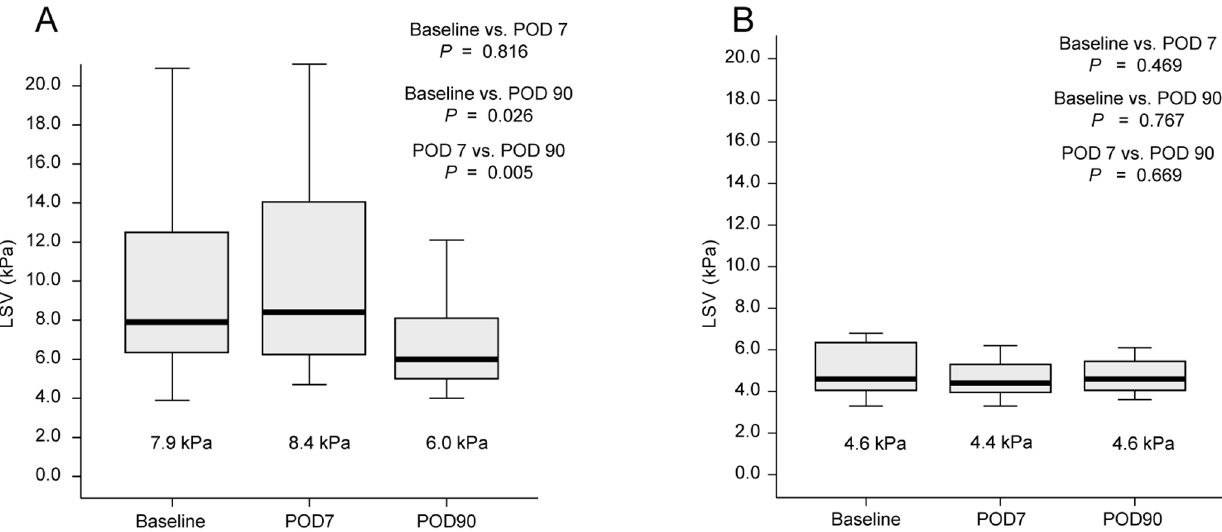
Figure 1. Liver stiffness at baseline, POD7, and POD90. (A) Patients with valve operation; LS increased minimally on POD7, but decreased significantly on POD90. (B) Patients with varicose vein operation; LS remained normal without significant interval changes during the study period. LS, liver stiffness; POD, post-operative day.